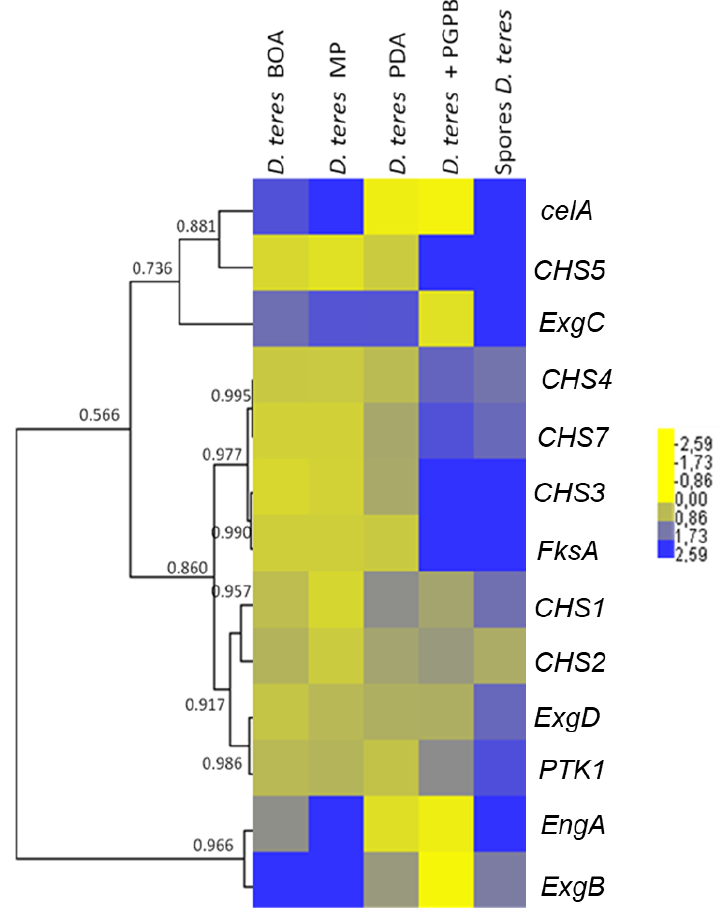
Figure 5. Heatmap hierarchical clustering with correlation coefficients of genes related to cell wall synthesis in D. teres . The heat map hierarchical clustering was generated using Pearson correlation in complete linkage.